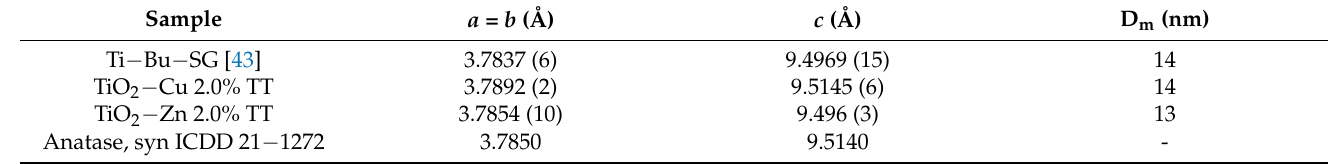
Table 3. XRF results of the analysed samples.